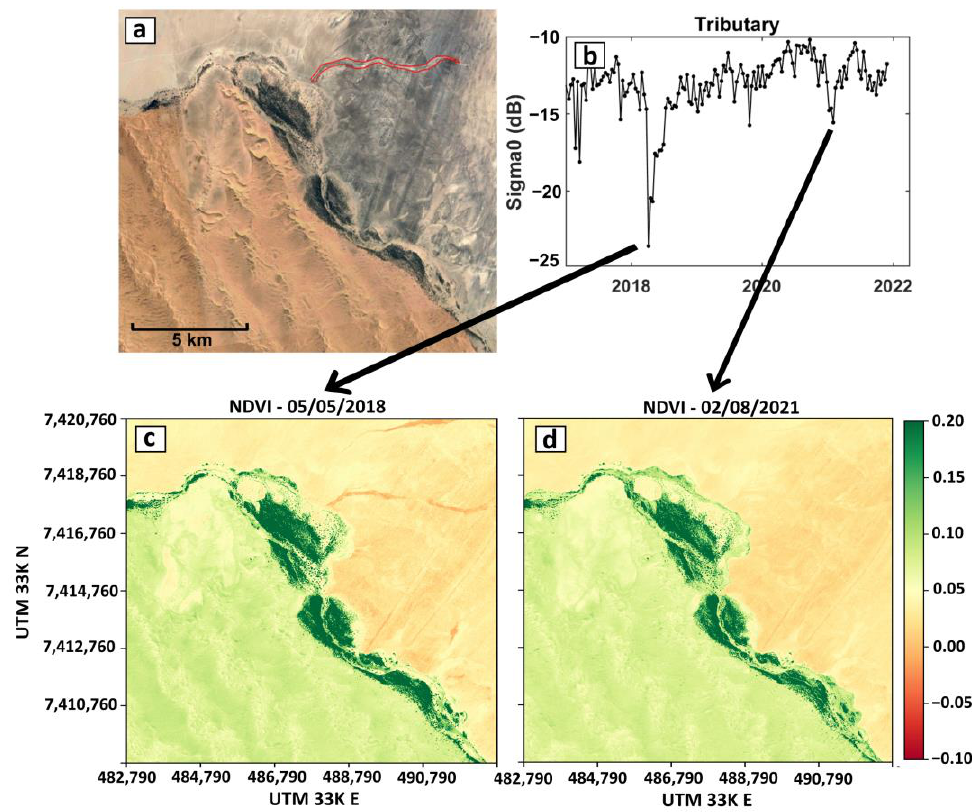
Figure 7. ( a ) The tributary at Klipneus in the central part of our lower Kuiseb River study area, ( b ) changes of the amplitude σ 0 (VV polarization) over the 2016–2022 period in the tributary, ( c ) corresponding NDVI map from 2018, and ( d ) NDVI map from 2021.